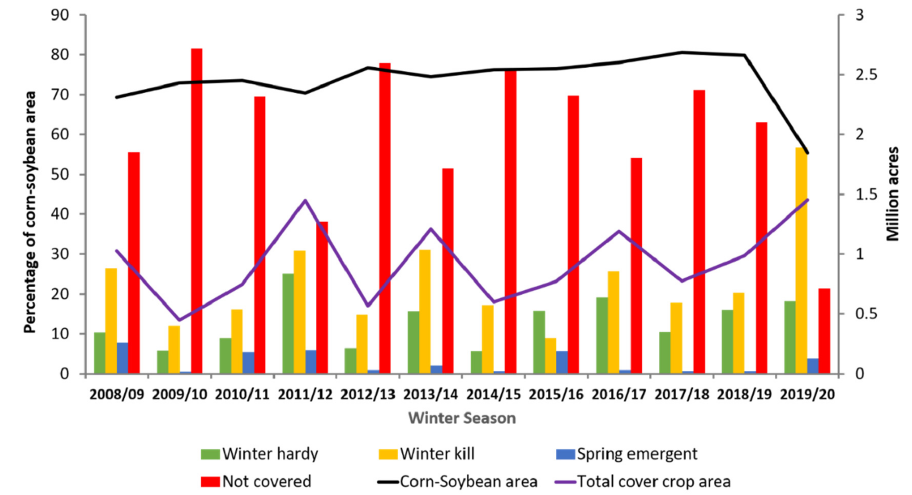
Figure 6. Annual variability of cover crop areas between 2008–2019. Note: the % area was computed based on total annual corn-soybean area per year. The x-axis represents the winter season. The total cover crop area represents all Winter Hardy, Winter Kill, and Spring Emergent classes. The secondary y-axis on the right represents areas (in terms of million acres) for either total cover crop or corn-soybean.